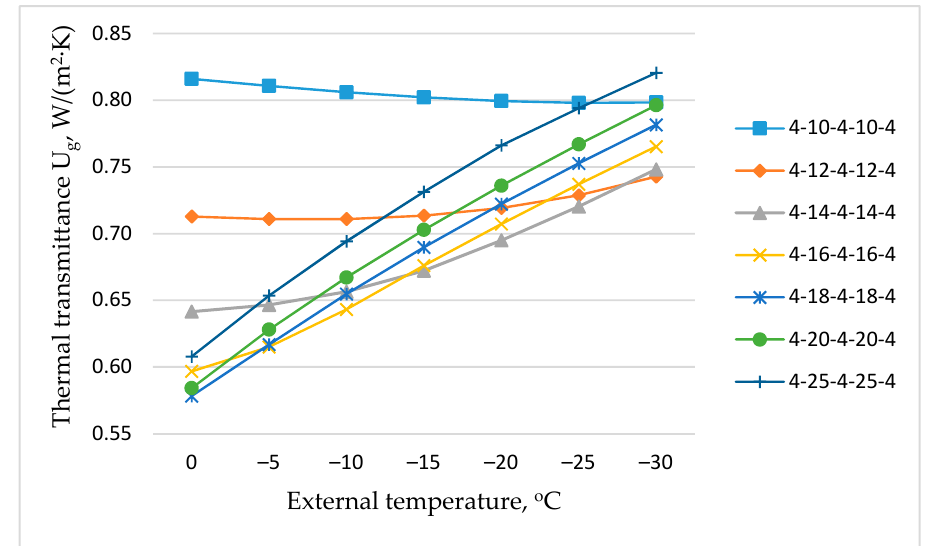
Figure 7. Dependence of the U g -value of the triple-glazed IGU on the distance between the panes and external air temperature.